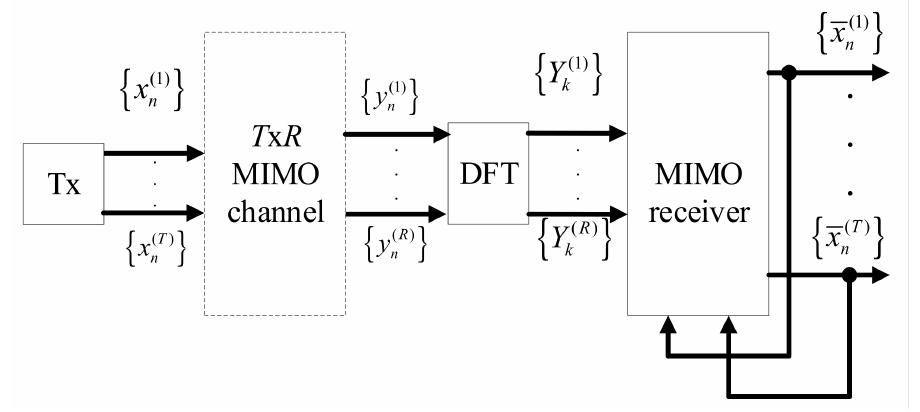
Figure 2. Block diagram of m-MIMO system with SC-FDE